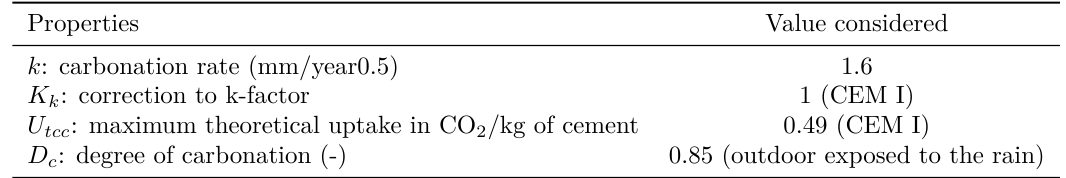
Table 4. Details of the considered value for the calculation with the NF EN 16757 model.